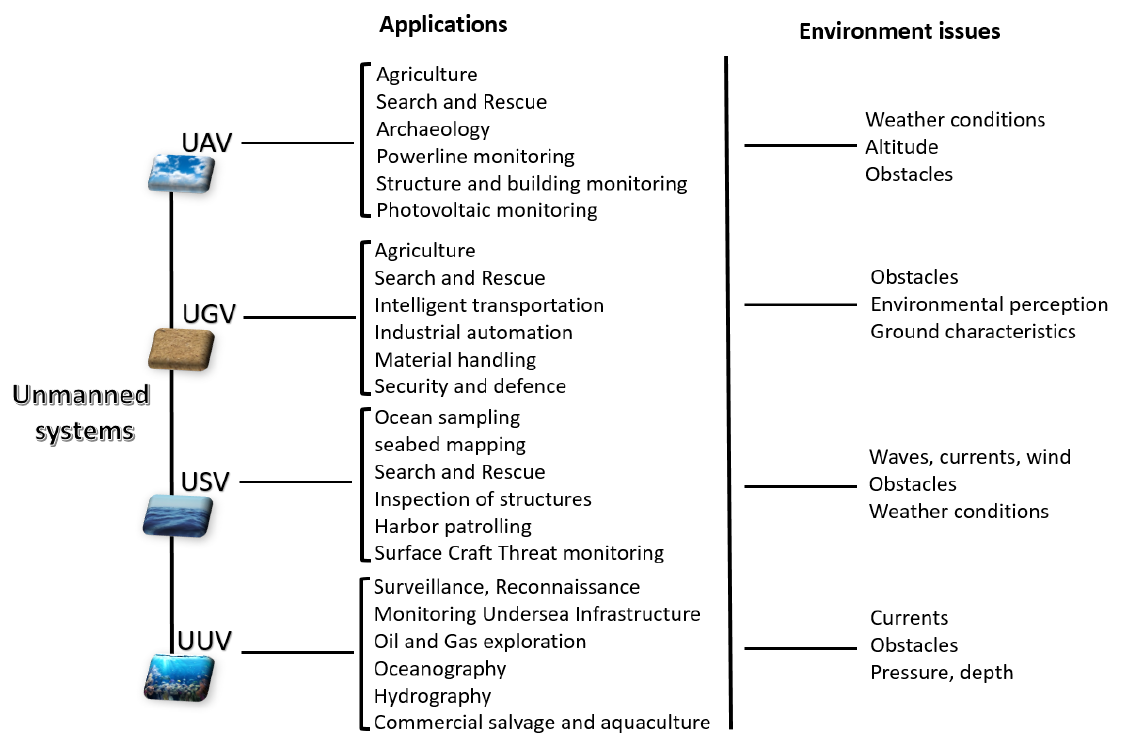
Figure 1. Unmanned system types and their critical environmental factors.